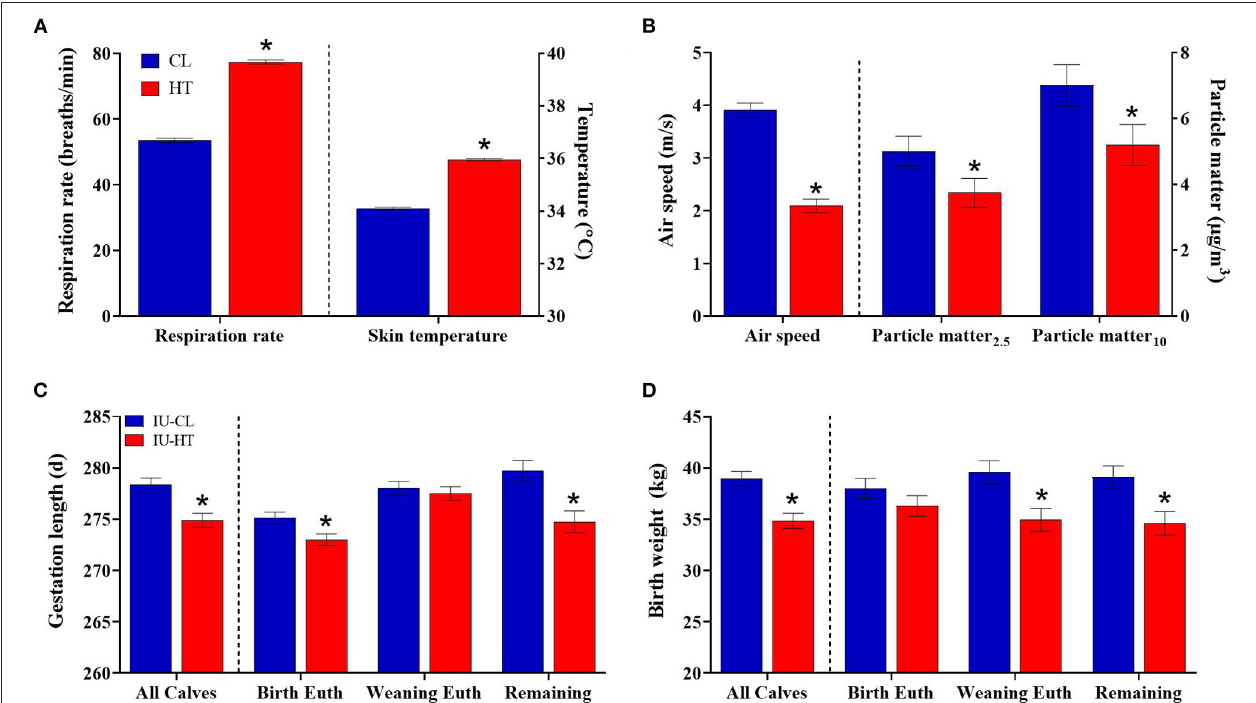
FIGURE 1 | Dam thermoregulatory and birth outcomes upon exposure to late-gestation heat stress (HT, red bars; n = 41) or cooling (CL, fans and soakers, blue bars; n = 41). (A) Respiration rate and skin temperature across the dry period of HT or CL dams, and (B) environmental measures of HT and CL pens including air speed and particle matter. Gestation length (C) and birth weight (D) of heifers exposed to late gestation in utero HT (IU-HT, red bars, n = 36) or CL (IU-CL, blue bars, n = 37). The graphs depict all heifers per treatment plus subgroups of heifers euthanized at birth ( n = 8 per in utero treatment), euthanized at weaning ( n = 8 per in utero treatment), and the remaining calves ( n = 20, IU-HT; n = 21, IUCL). Data is presented as LSM ± SE of the main effect of in utero treatment. *Indicates significance ( P ≤